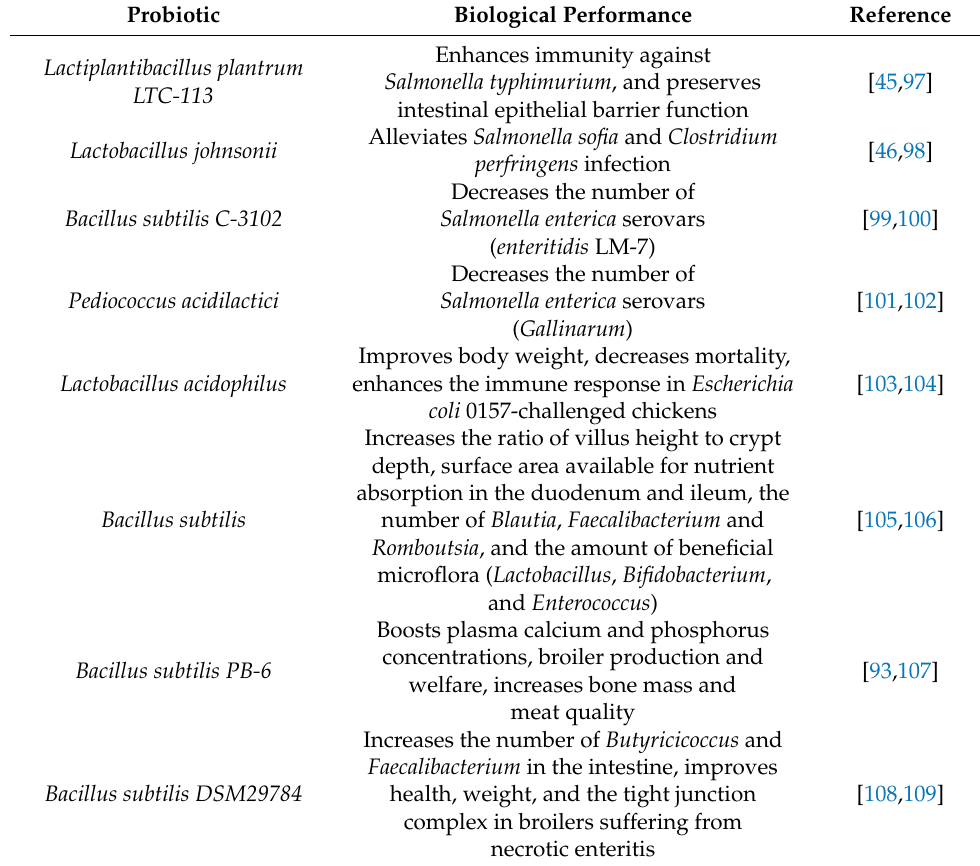
Table 2. An overview of the use of bacteria beneficial in poultry